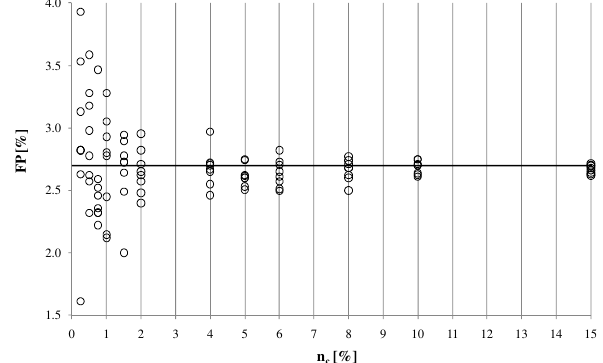
Fig. 1. Failure percentages (FP), computed by different runs of the Figure 1. Failure percentages (FP), computed by different runs of the model, depending on the 2 model, depending on the ratio ( n c ) among the number of compu- ratio ( n c ) among the number of computational cells included in the sample and the total 3 tational cells included in the sample and the total amount of basin amount of basin cells. 4 cells.